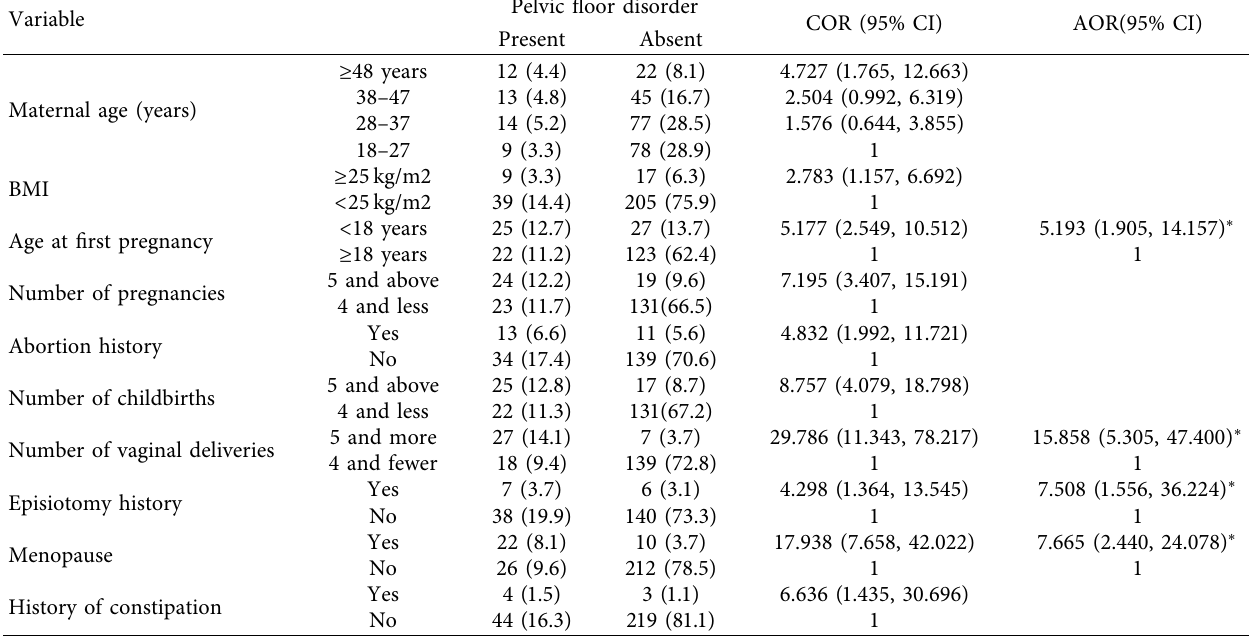
Table 6: Factors associated with PFD among study